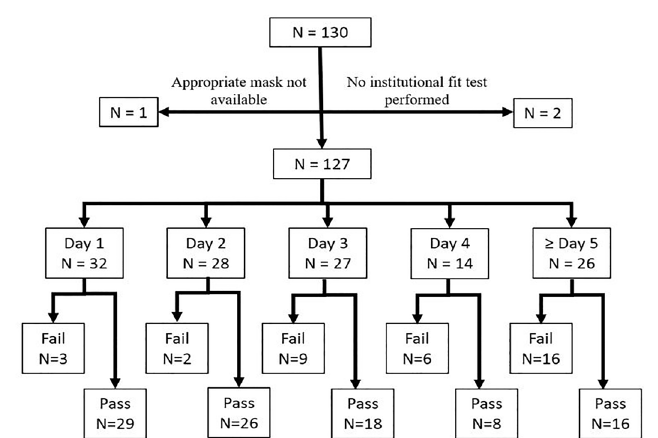
Figure 1. Flow diagram of study subjects demonstrating mask distribution based on day of use as well as “pass” and “fail” rates.